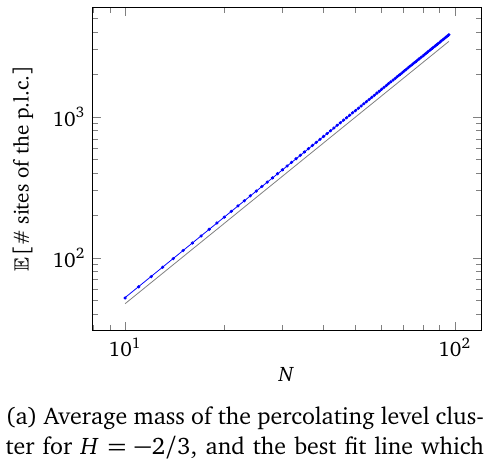
(a) Average mass of the percolating level clus- (b) Convergence of the best fit parameter for ter for H = − 2 / 3, and the best fit line which the fractal dimension when the lowest size has slope ∼ 1.90. The gray line corresponds to points are removed. Here it converges to the = 91 / 48 ∼ 1.8958. the percolation value D percolation value shown as a grey line. f